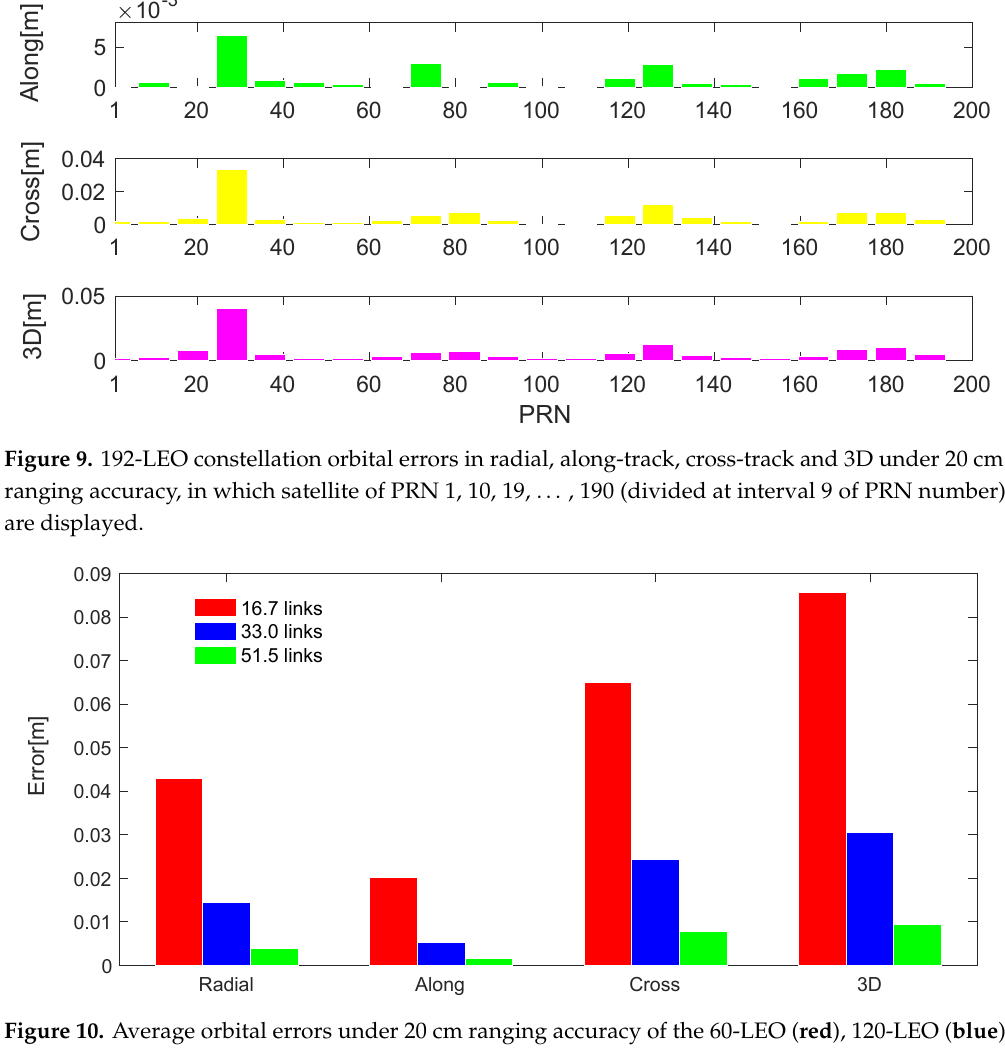
Figure 10. Average orbital errors under 20 cm ranging accuracy of the 60-LEO ( red ), 120-LEO ( blue ) and 192-LEO ( green ) constellations.